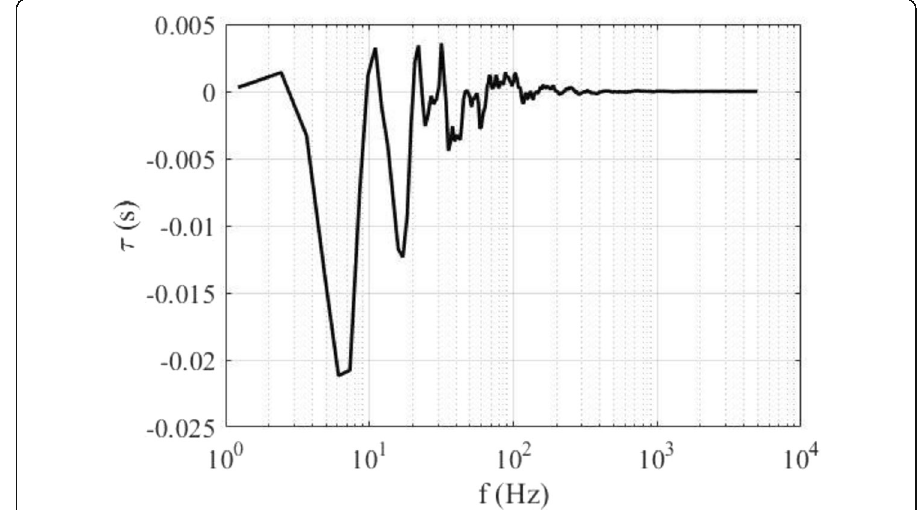
Fig. 18 Time lag magnitude variation with frequency of data associated with locations near the shock wave and in the downstream boundary layer, for data acquired on 05 April 2018. Note that positive time lag values indicate the signal in the boundary layer (for a particular frequency) occurs prior to the signal (at the same frequency) which is associated with the normal shock